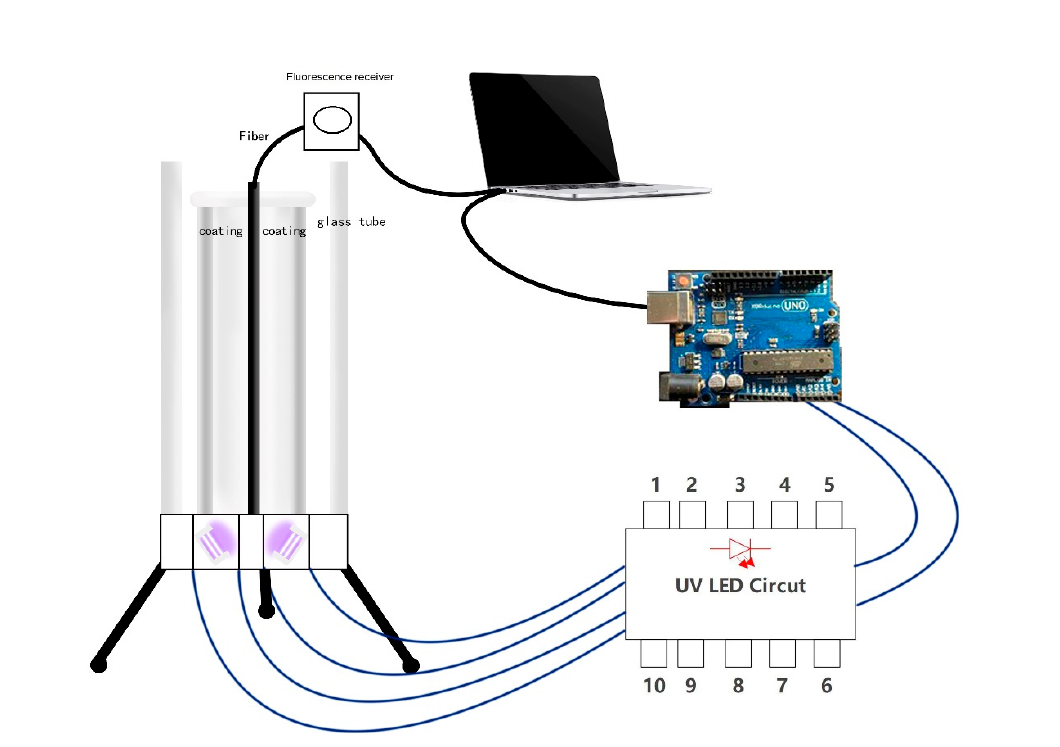
Figure 8. Sketch of sensor and illustration of connecting